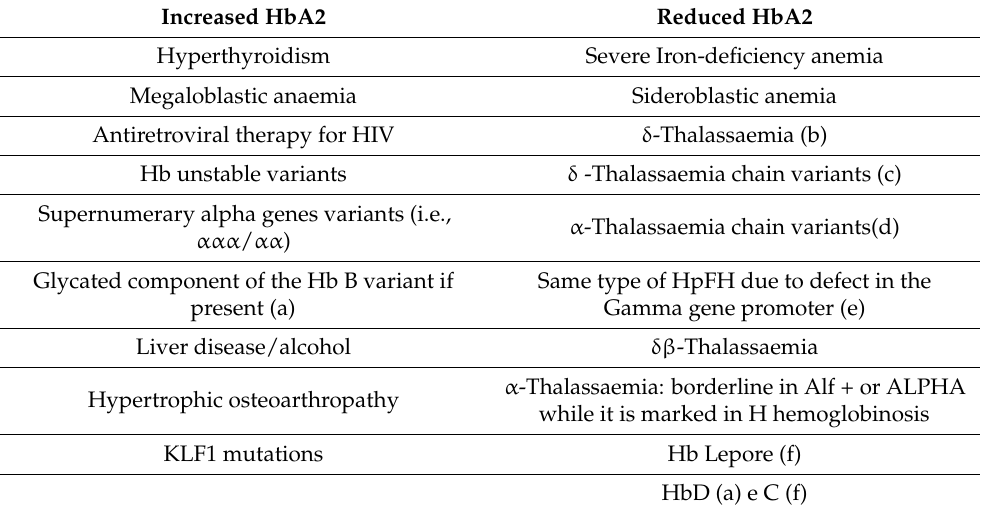
Table 4. Main individual preanalytical variables that can modify the value of HbA2.